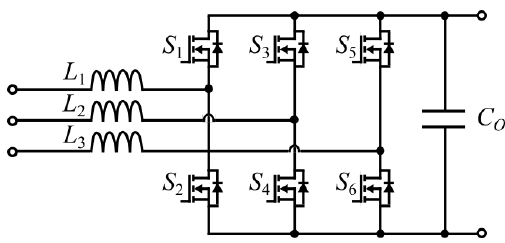
Figure 7. Three-phase two-level six-switch boost-type